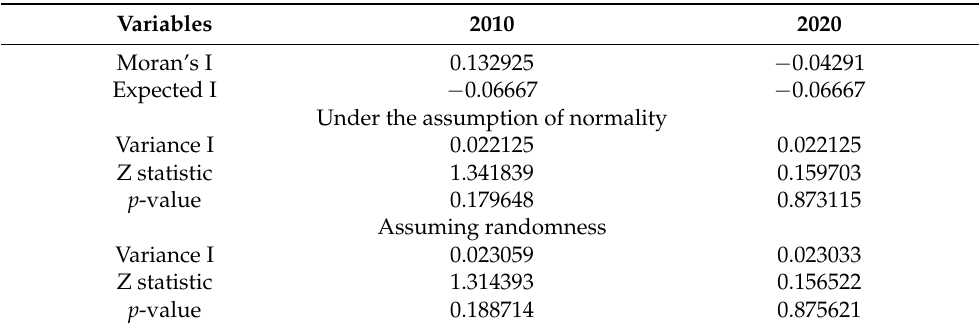
Table 5. Values of the global Moran’s I statistics for the synthetic measure of the quality of life in voivodeships in Poland (in 2010 and